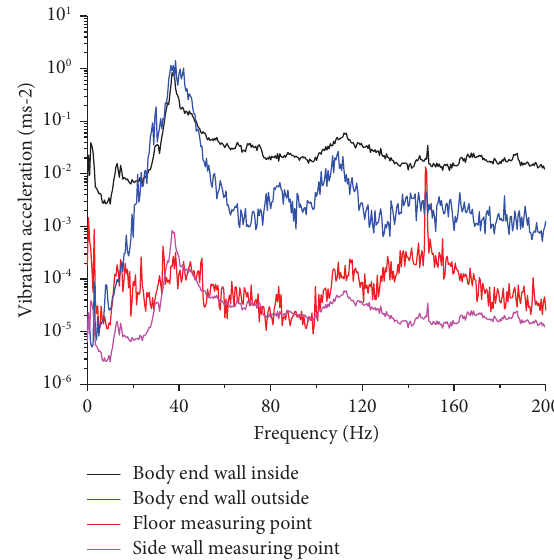
Figure 4: Vibration spectrum diagram of the inner and outer measuring points of the car body end wall, foor, and side wall.